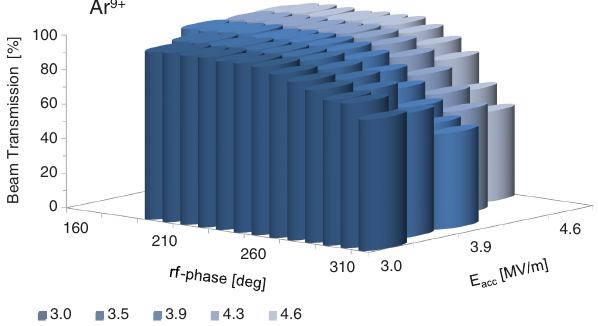
FIG. 11. 3D scan of Ar 9 þ -beam transmission versus accelerat- ing gradient and rf phase.